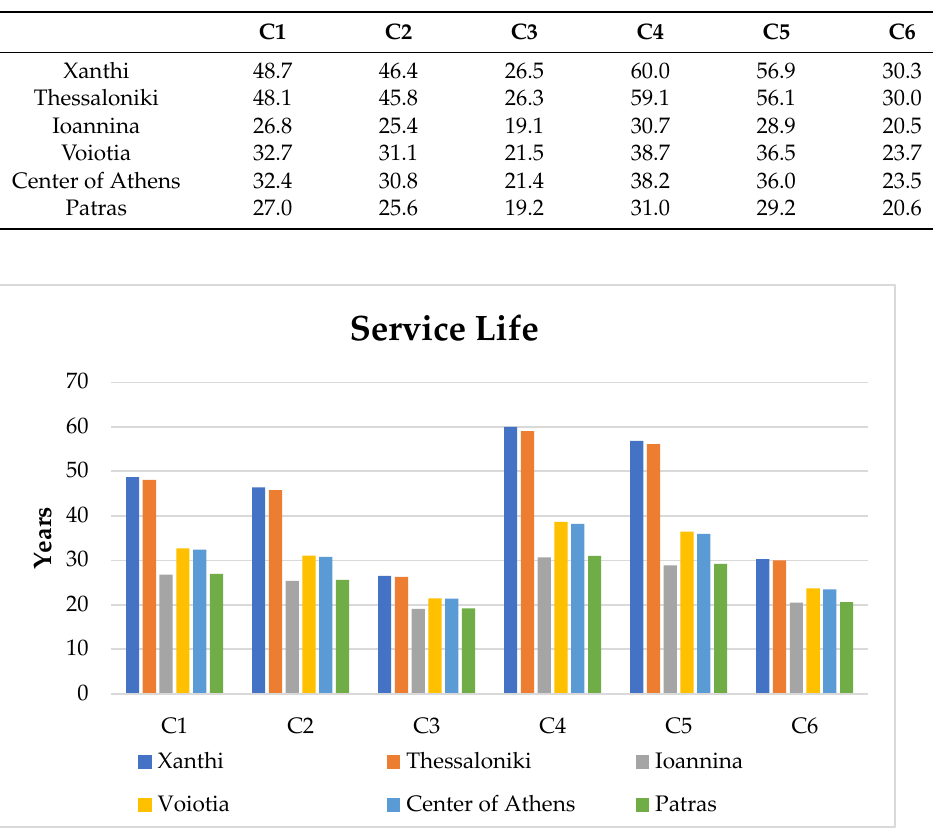
Figure 13. Service life of concrete mixtures due to carbonation.